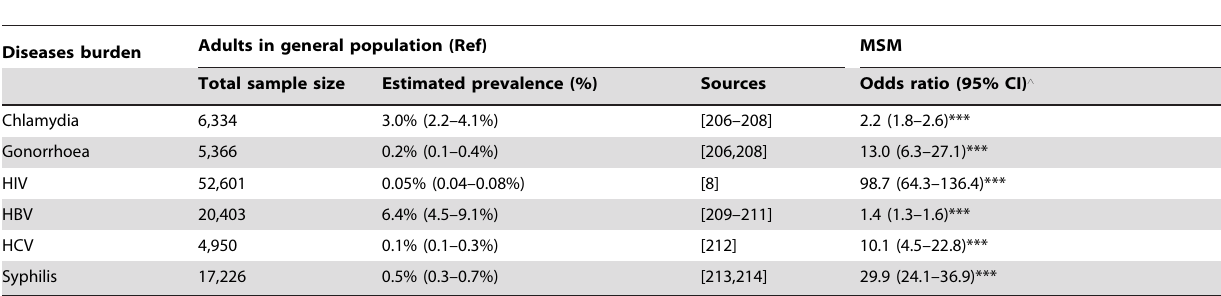
Table 2. Comparison of hepatitis infections and STIs prevalence among MSM and adults in general population in China.